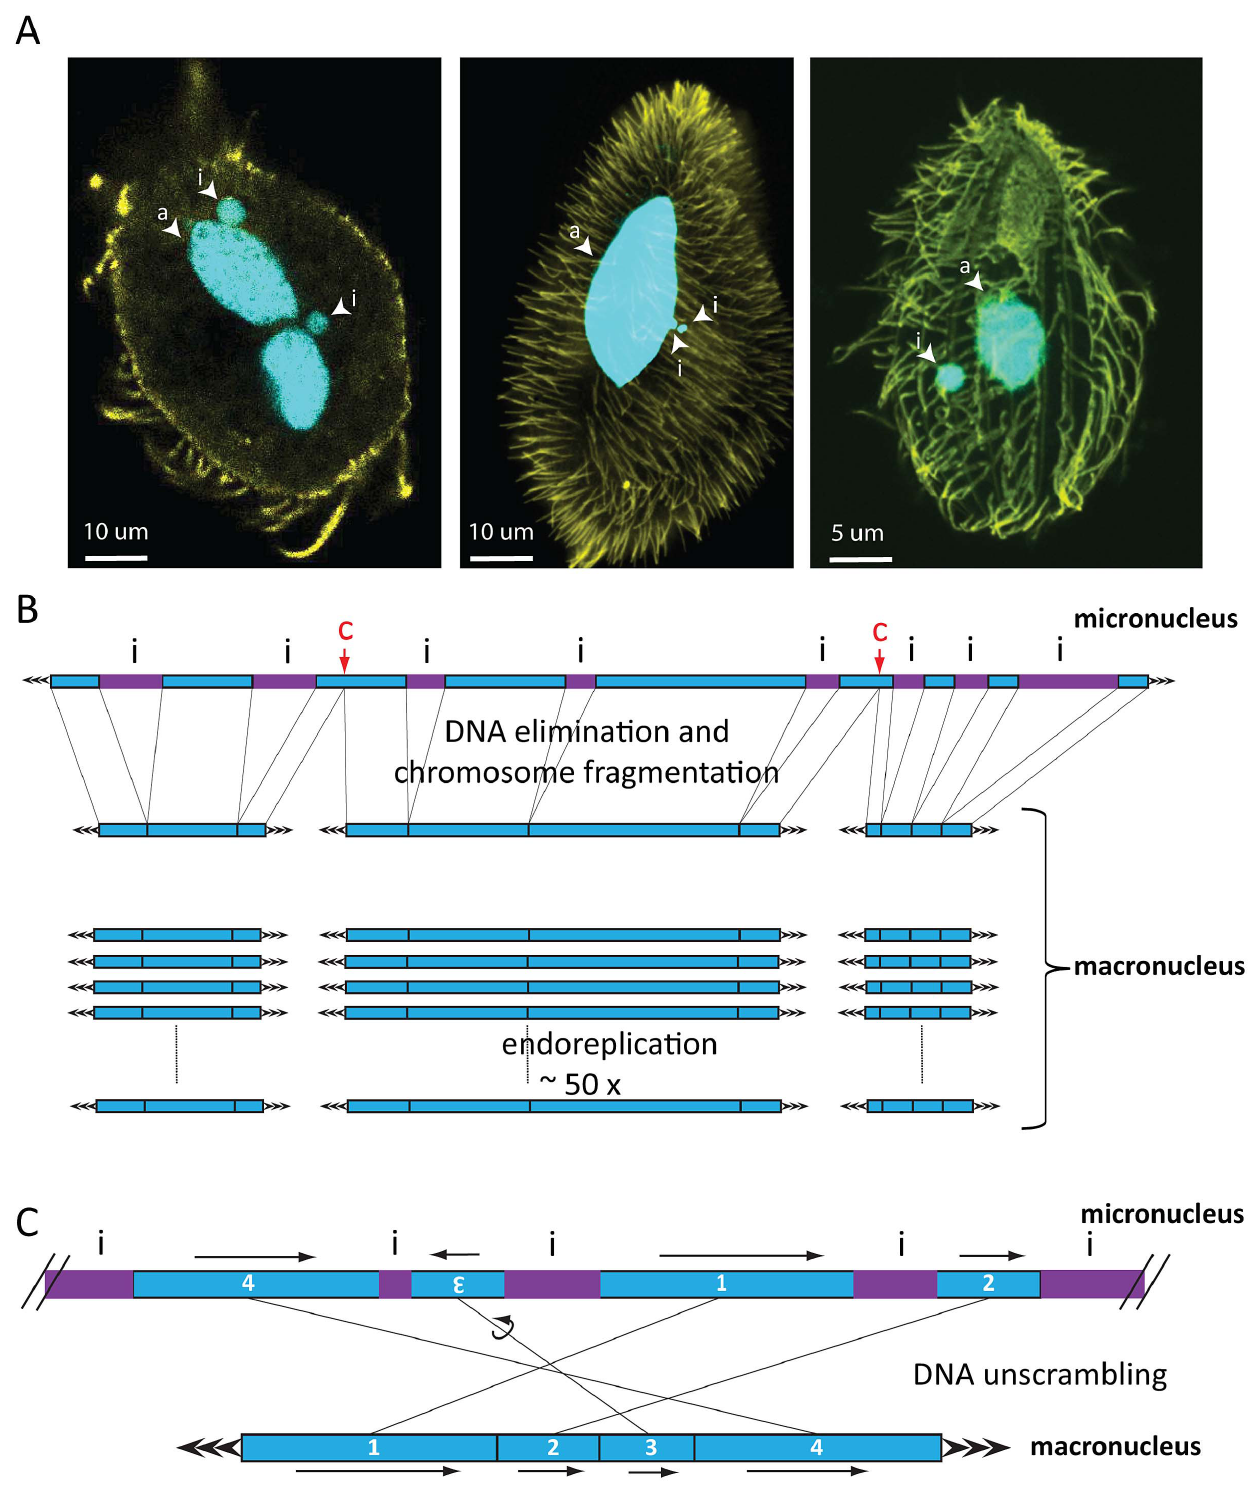
Figure 1. Nuclear dimorphism and genome rearrangements in ciliates. A) From left to right: Oxytricha trifallax , Paramecium tetraurelia , Tetrahymena thermophila . DNA is shown in cyan, yellow represents tubulin staining. Images were kindly provided by Wenwen Fang (Princeton University, Princeton), Kensuke Kataoka (IMBA, Vienna), and Janine Beisson (CNRS, Gif sur Yvette). Abbreviations: i=micronucleus, a=macronucleus. In Oxytricha trifallax , two lobes of a macronucleus are connected by a thin nuclear bridge (not visible in the image). B) Genome rearrangements in all ciliates shown include elimination of micronucleus (MIC)-limited sequences (i, purple IES) and chromosome breakage, which in Tetrahymena occurs at specific chromosome breakage sites (labeled c). After religation of the flanking macronuclear (MAC) sequences, Tetrahymena chromosomes undergo endoreplication to produce 50 identical copies. C) DNA unscrambling in Oxytricha involves the reshuffling and occasional inversion of precursor micronuclear (MIC) sequences (numbered blue boxes) to assemble them in the correct macronuclear